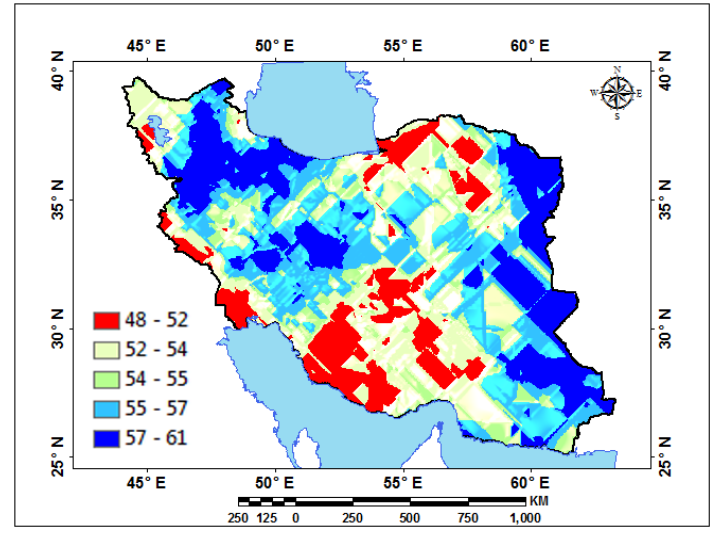
Figure 12. Forecast of spring rainfall variations (seasonal additive model).